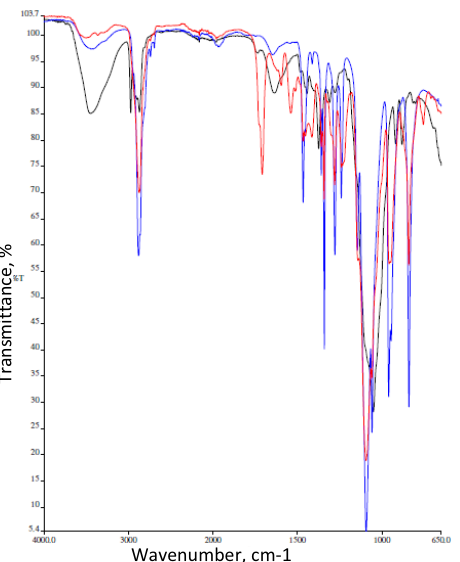
Figure 2. FTiR results for cellulose (black), pure PEG 4000 (blue) and S-S PCM containing 75% of PEG4000.